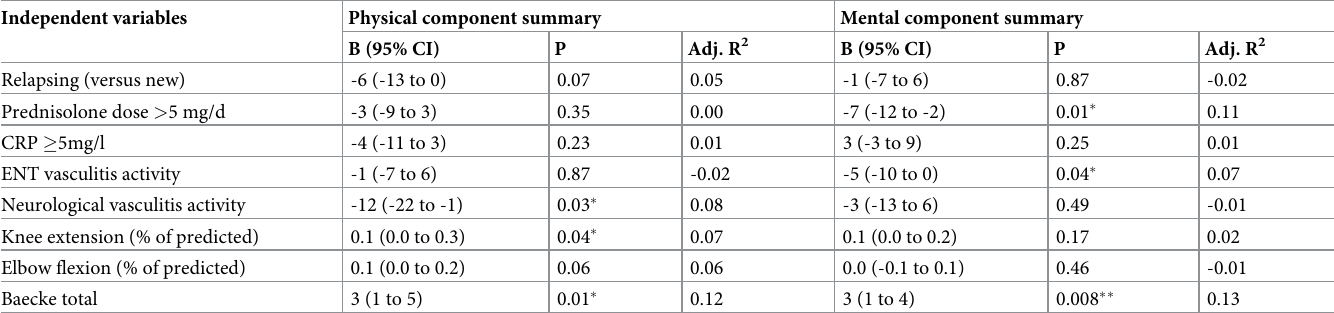
Table 2. Univariable linear regression for quality of life in ANCA associated vasculitis. Independent variables